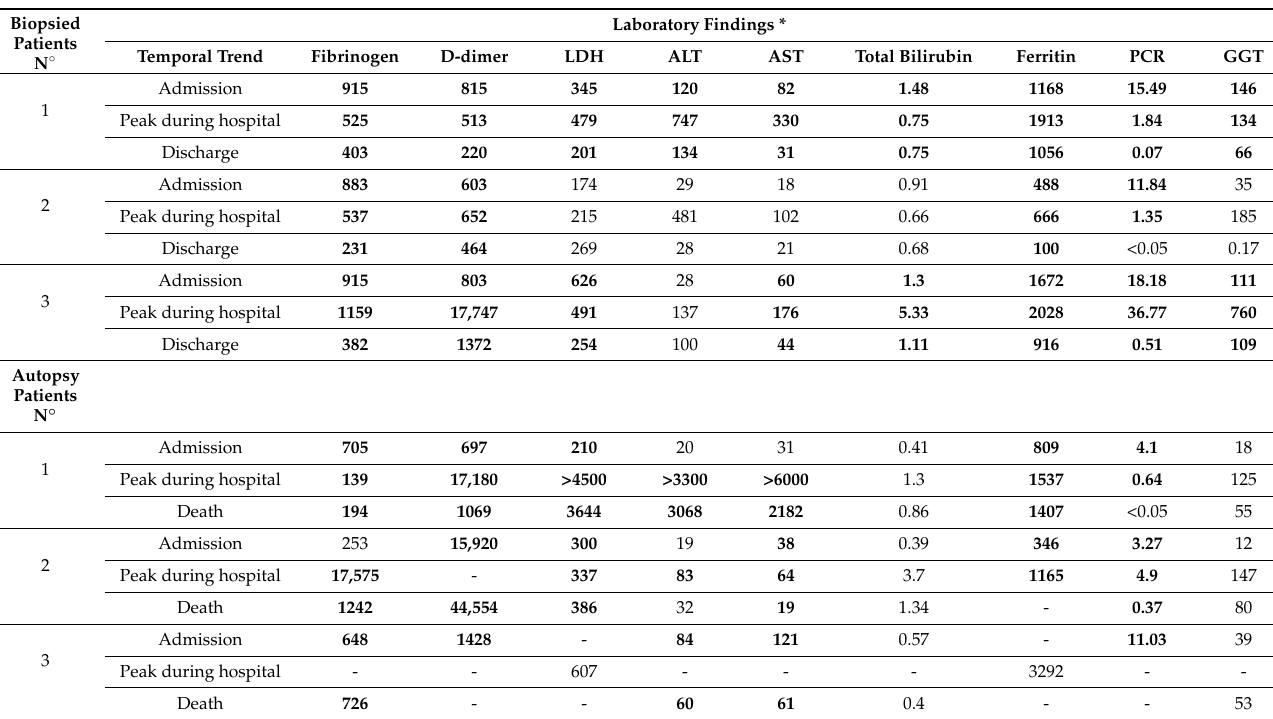
Liver enzymes, and AST and ALT levels, initially abnormal in three cases, increased in all patients during hospitalization. Ferritin levels were elevated in all patients (peak range 670–3292 µ g/L). Some patients showed a cholestatic pattern (mild to moderate elevation of gamma glutamyl transpeptidase and direct bilirubin levels) (Table